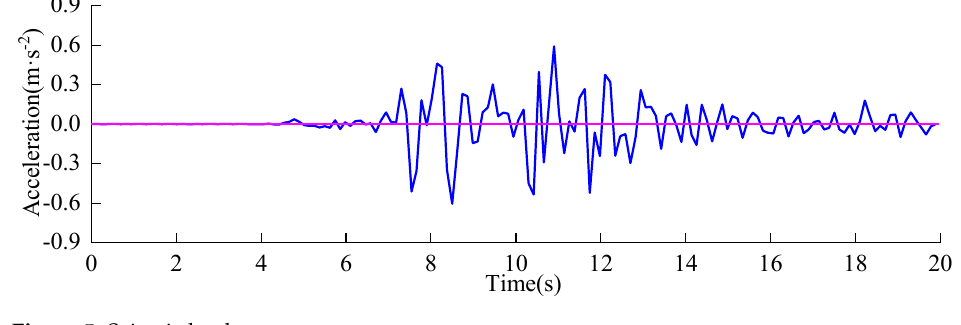
Figure 5. Seismic load.